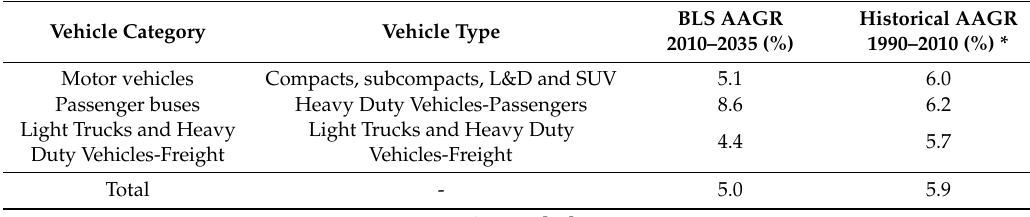
historical evolution.